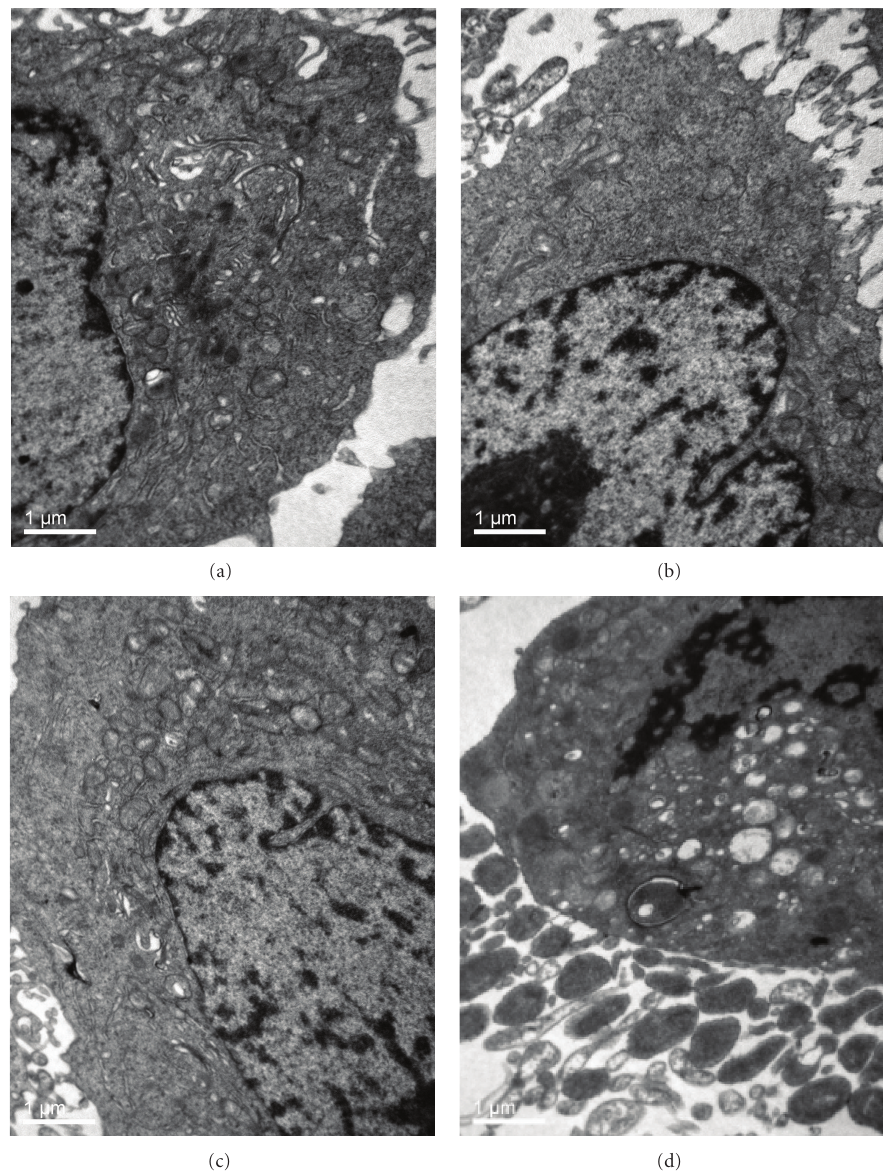
Figure 2: Mitochondrial morphological changes in HO-8910 cells were observed using TEM 6 h after photodynamic action of hypocrellin B ( × 15,000). (a): Sham irradiation; (b): hypocrellin B treatment alone; (c): light irradiation alone; (d): photodynamic action of hypocrellin